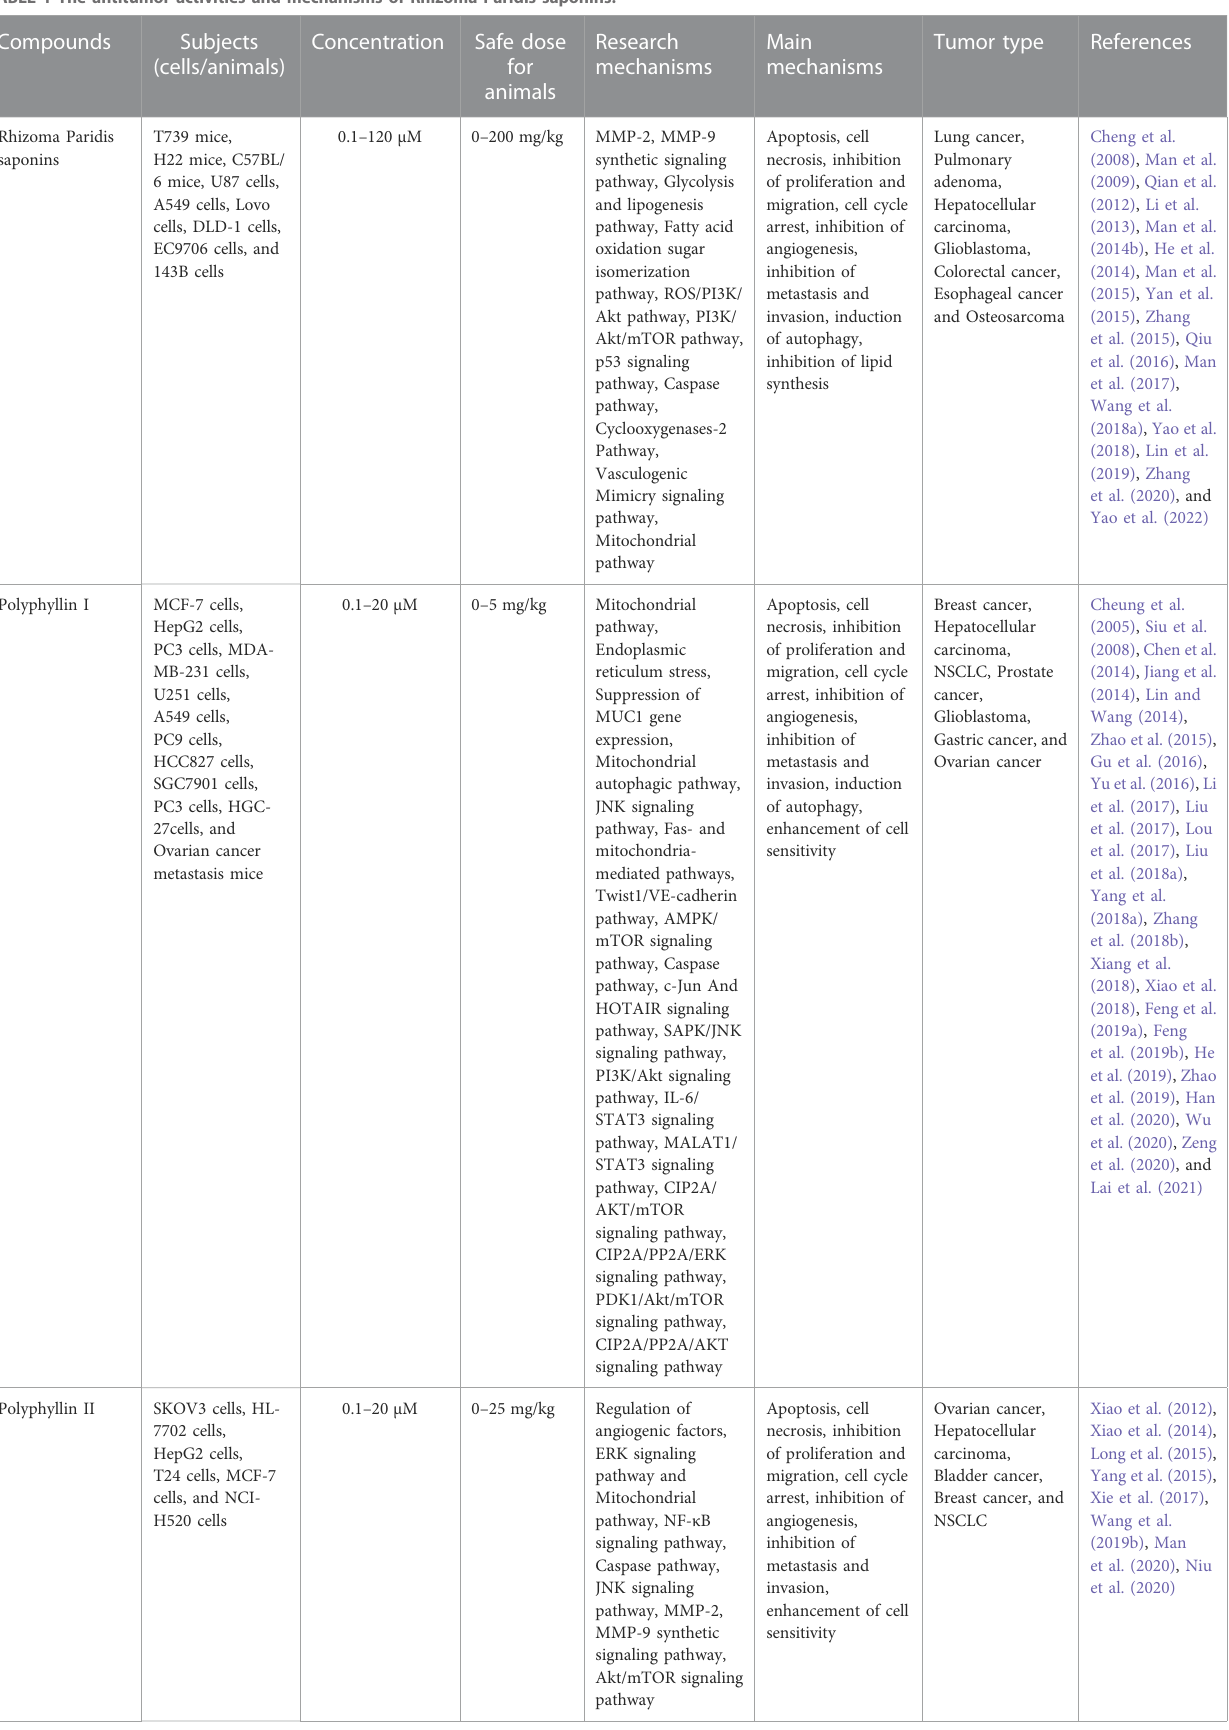
TABLE 1 The antitumor activities and mechanisms of Rhizoma Paridis saponins.